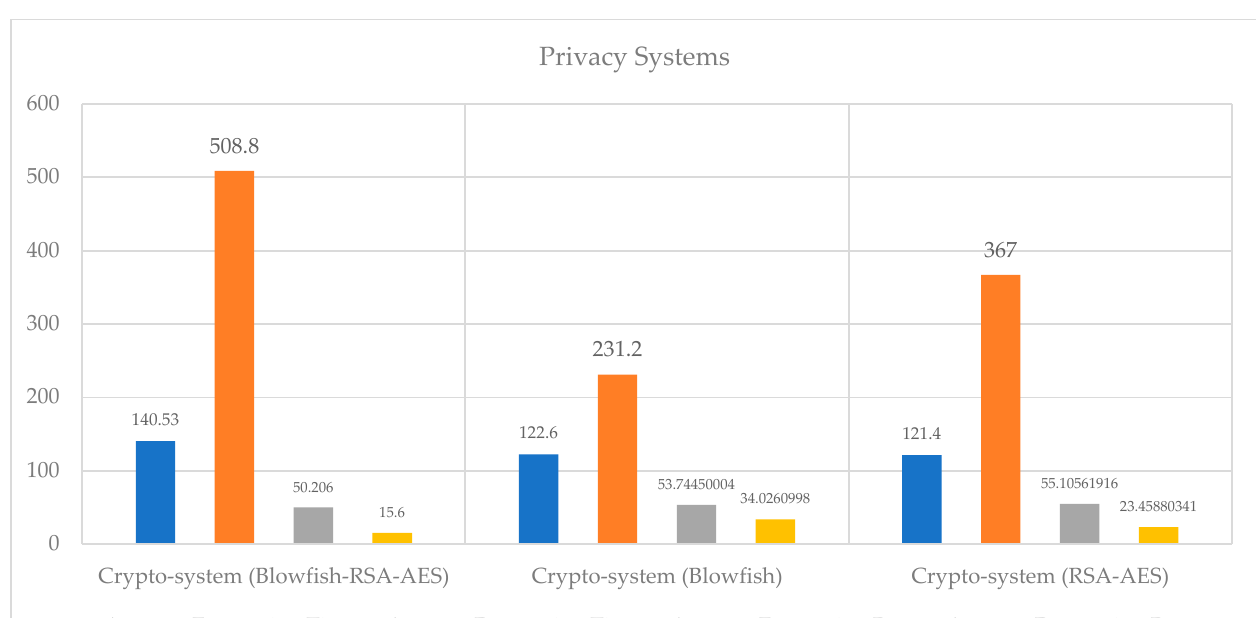
Figure 6. Read transaction throughput.